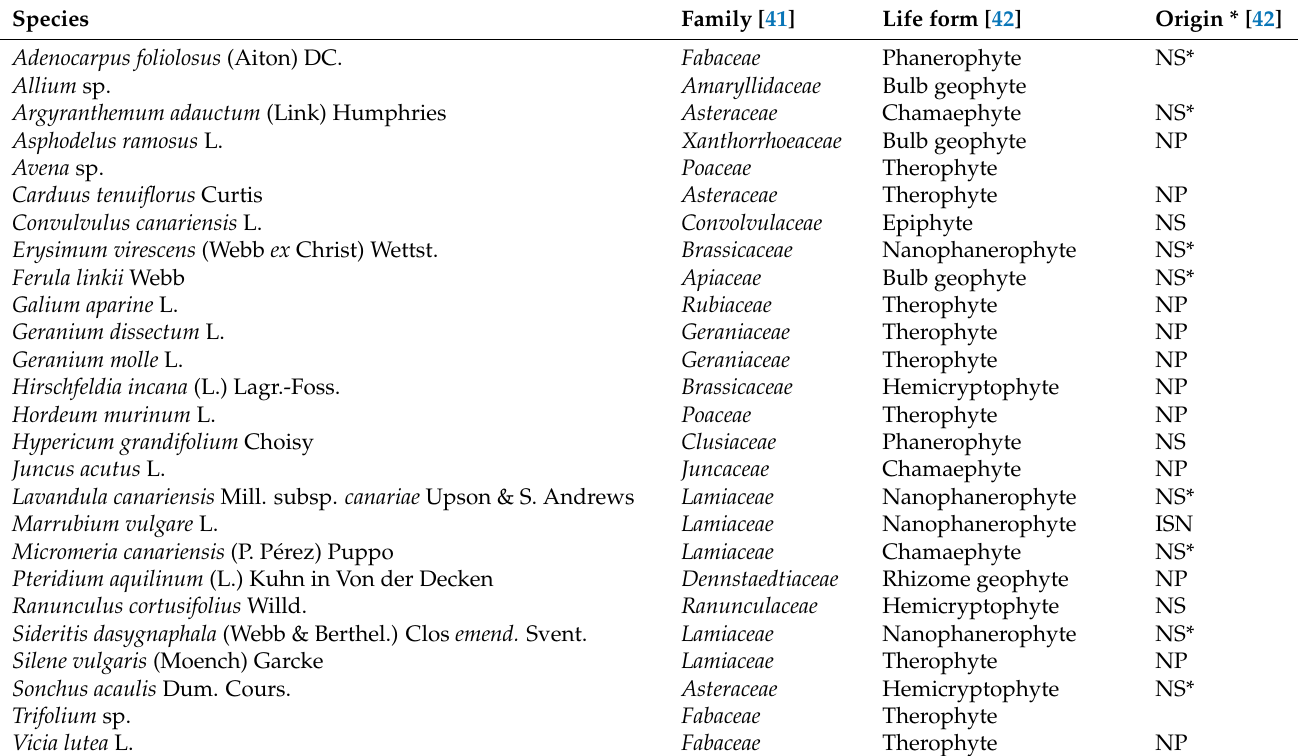
Table A1. List of species indicating family, life form and origin (sampled in the 1 × 1 m plots). Species Adenocarpus foliolosus (Aiton)